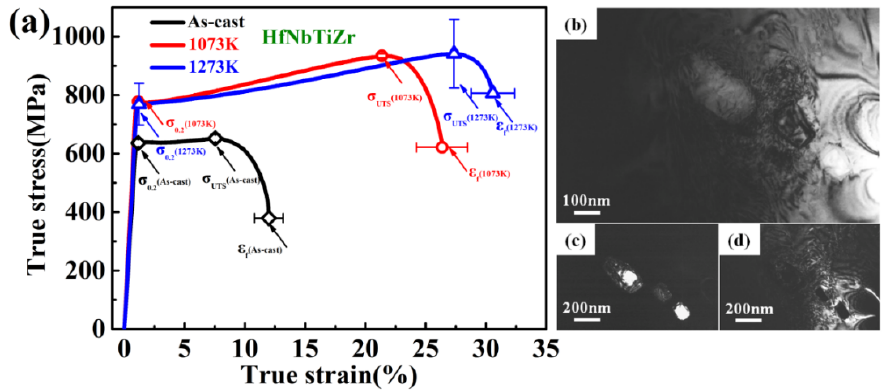
Figure 3. ( a ) Tensile true stress–strain curves of the as-cast, cold-rolled and annealed at 1073 and 1273 K RHEAs; ( b – d ) Bright-field (BF) and dark-field (DF) images of the hcp precipitates after tension.